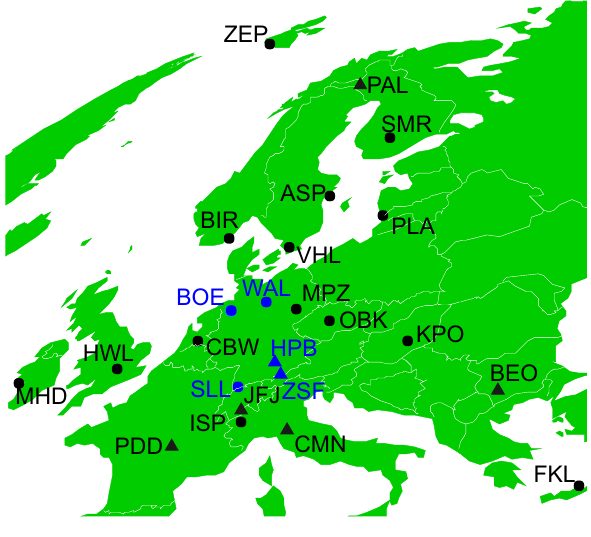
Fig. 2. Geographic distribution of stations used in this article. EU- SAAR stations are marked with black and GUAN stations in blue. Station MPZ belongs also to the GUAN network. Circles denote boundary layer sites and triangles sites of relatively high altitude. See Table 2 for stations’